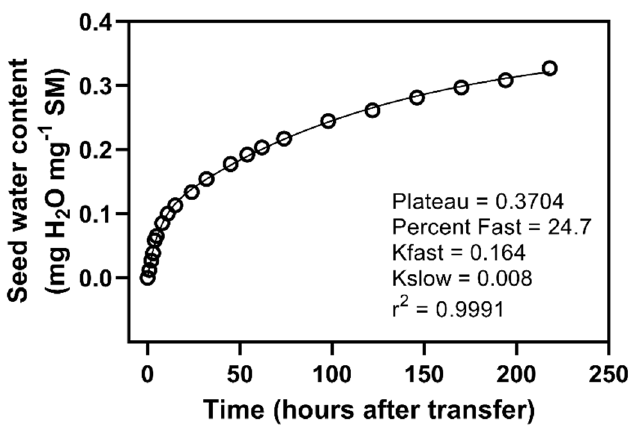
Figure 6. Isolated seed water uptake curve for seeds transferred from PEG to water after 96 h. A double-exponential curve has been fitted with the parameters reported.